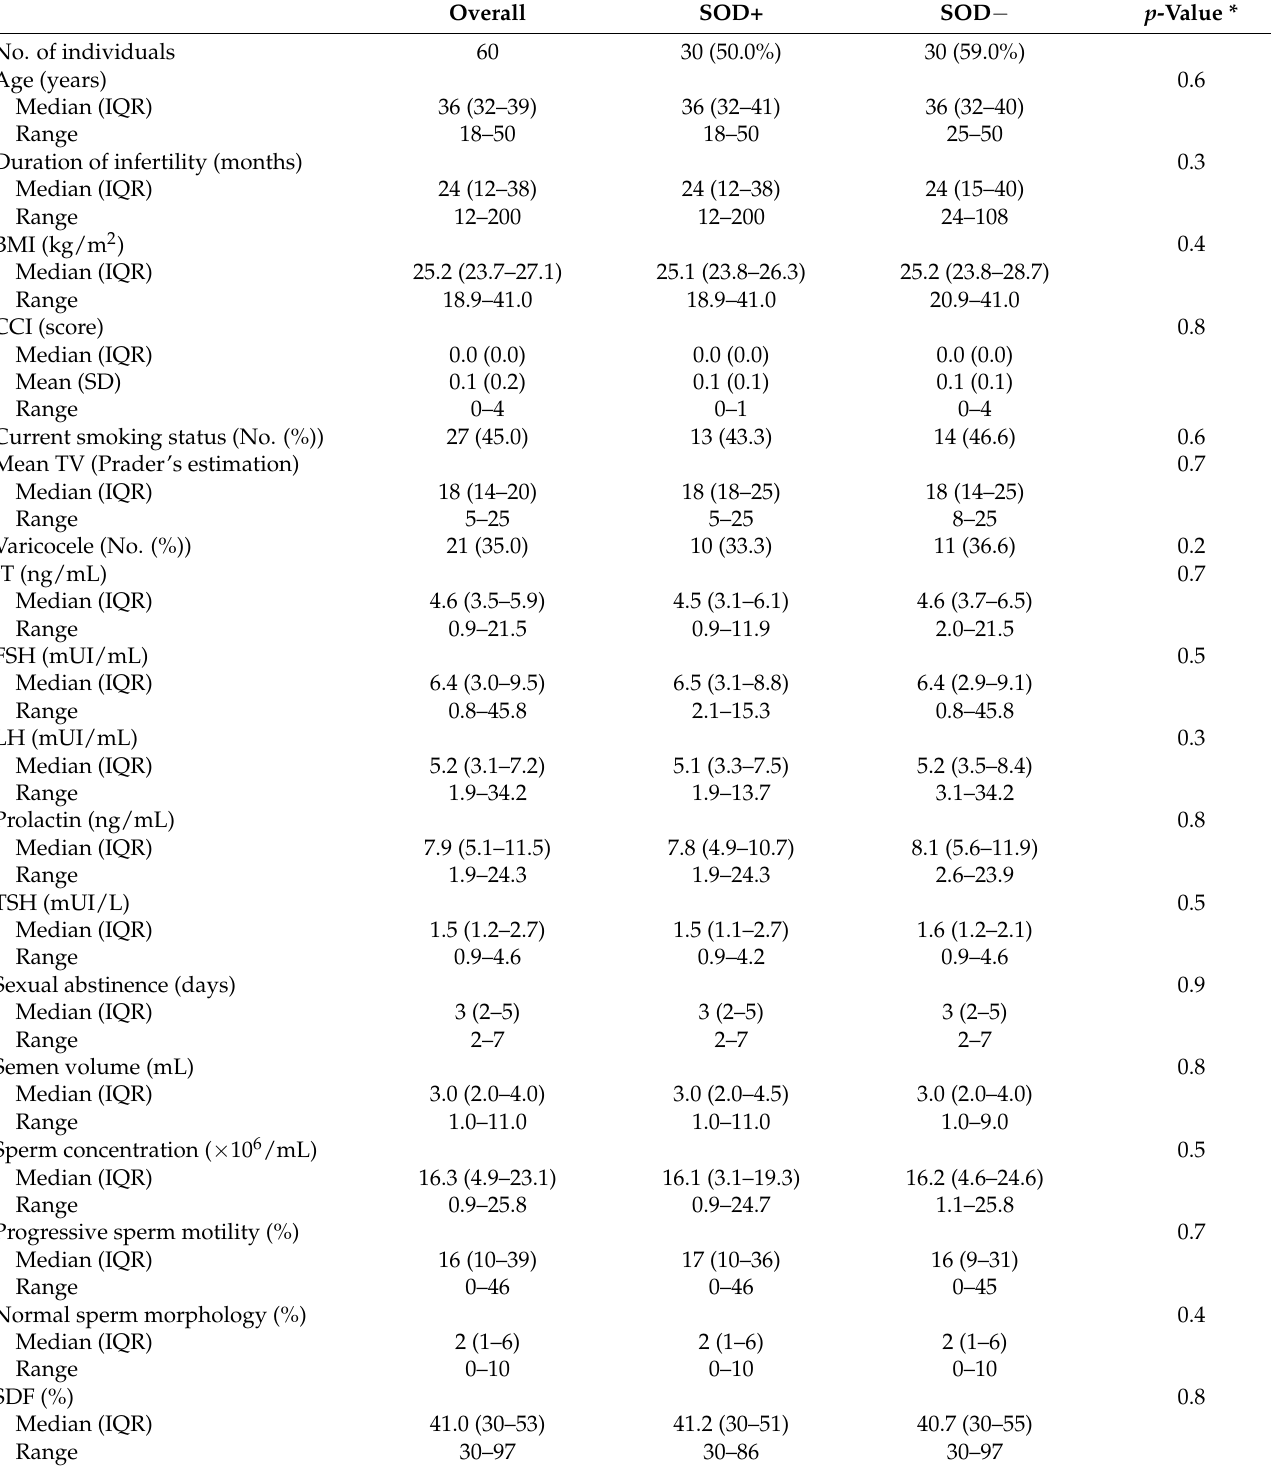
Table 1. Baseline characteristics of the whole cohort of patients ( n =